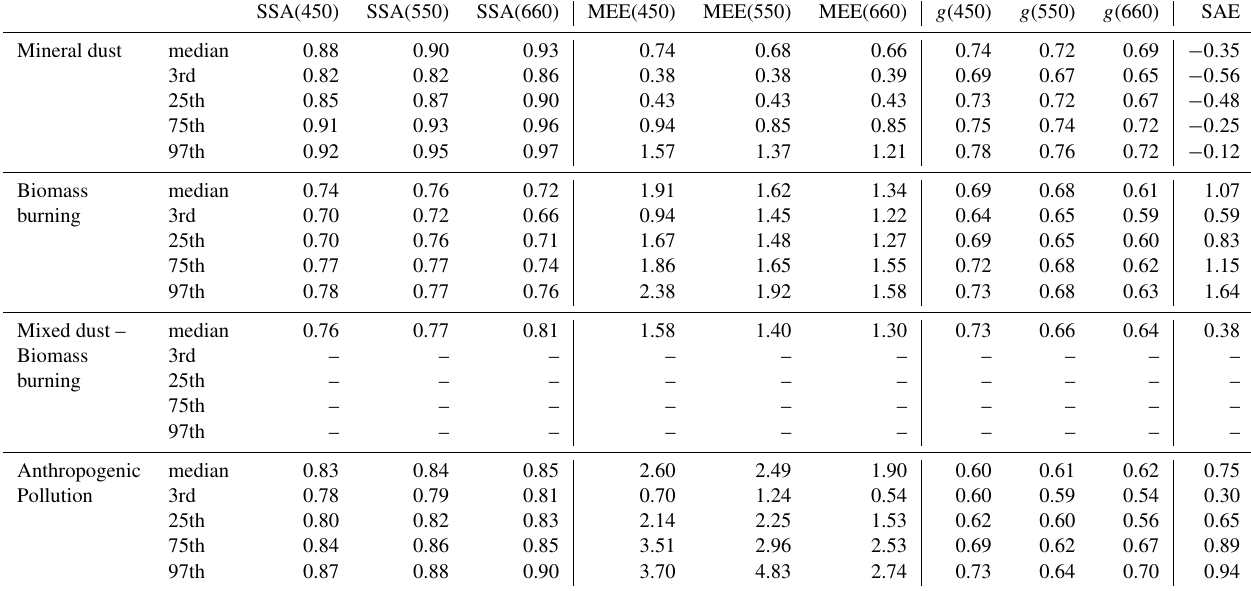
Table 2. Single scattering albedo, mass extinction efficiency (in m 2 g − 1 ), asymmetry parameter and scattering Ångström exponent for the dominant aerosol